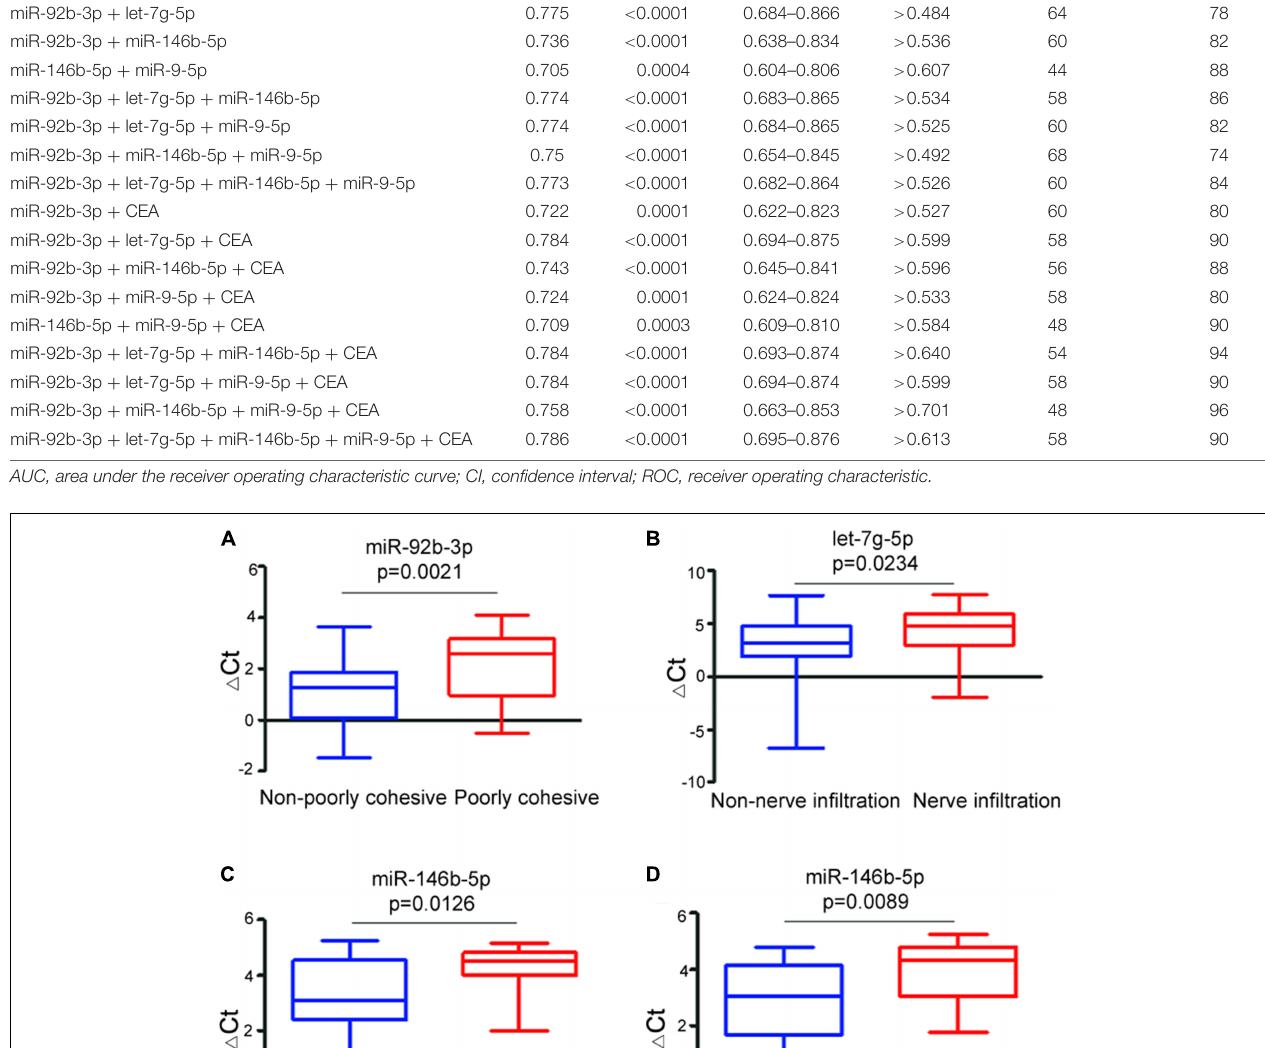
TABLE 3 | ROC curve analysis on combinations of serum exosomal miRNAs for early-stage gastric cancer. miRNA combination AUC p -Value 95% CI Cut - off